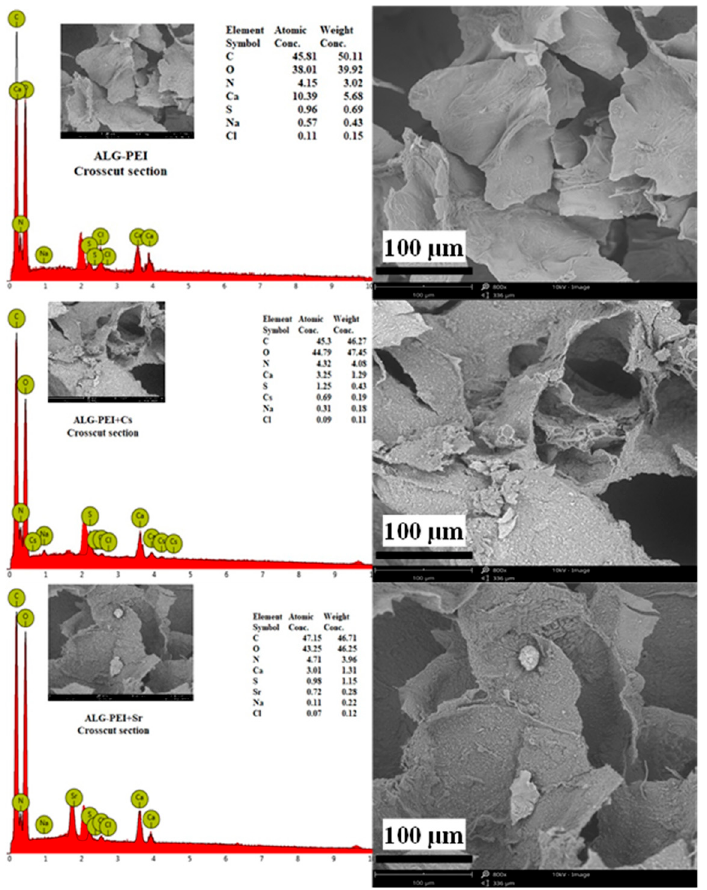
Figure A6. SEM-EDX analysis of cross-sections of ALG-PEI sorbent before and after Cs(I) and Sr(II) sorption.